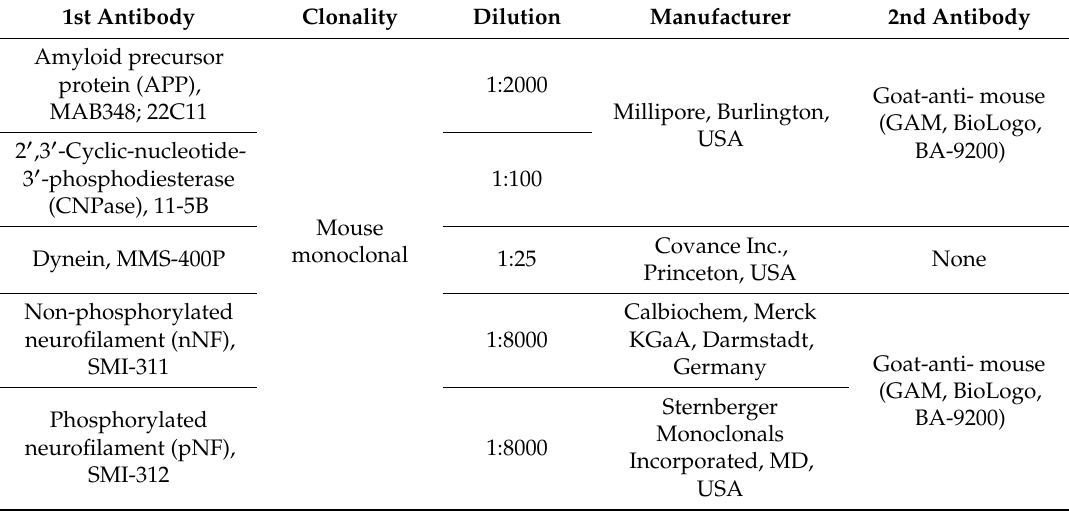
Table 1. Antibodies used for